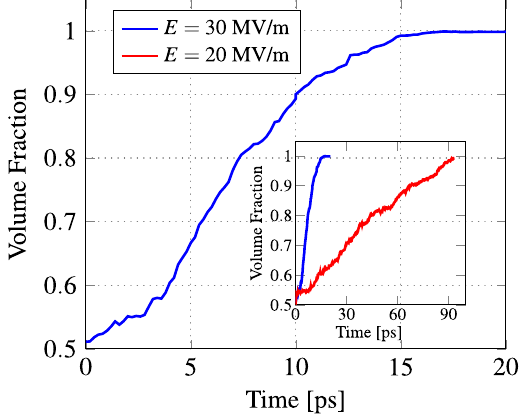
Figure 5. Evolution of the growing domain with time. The time-dependent volume fraction of the growing domain is computed for every 0.1 ps during the switching process under a strong electric field, E = 30 MV/m. After equilibration when the time is set to zero, due to thermal fluctuations, it is possible that the volume fraction of growing domain is very close but not exactly equal to 0.5. The inset shows the comparison with the time-dependent volume fractions under a weak electric field, E = 20